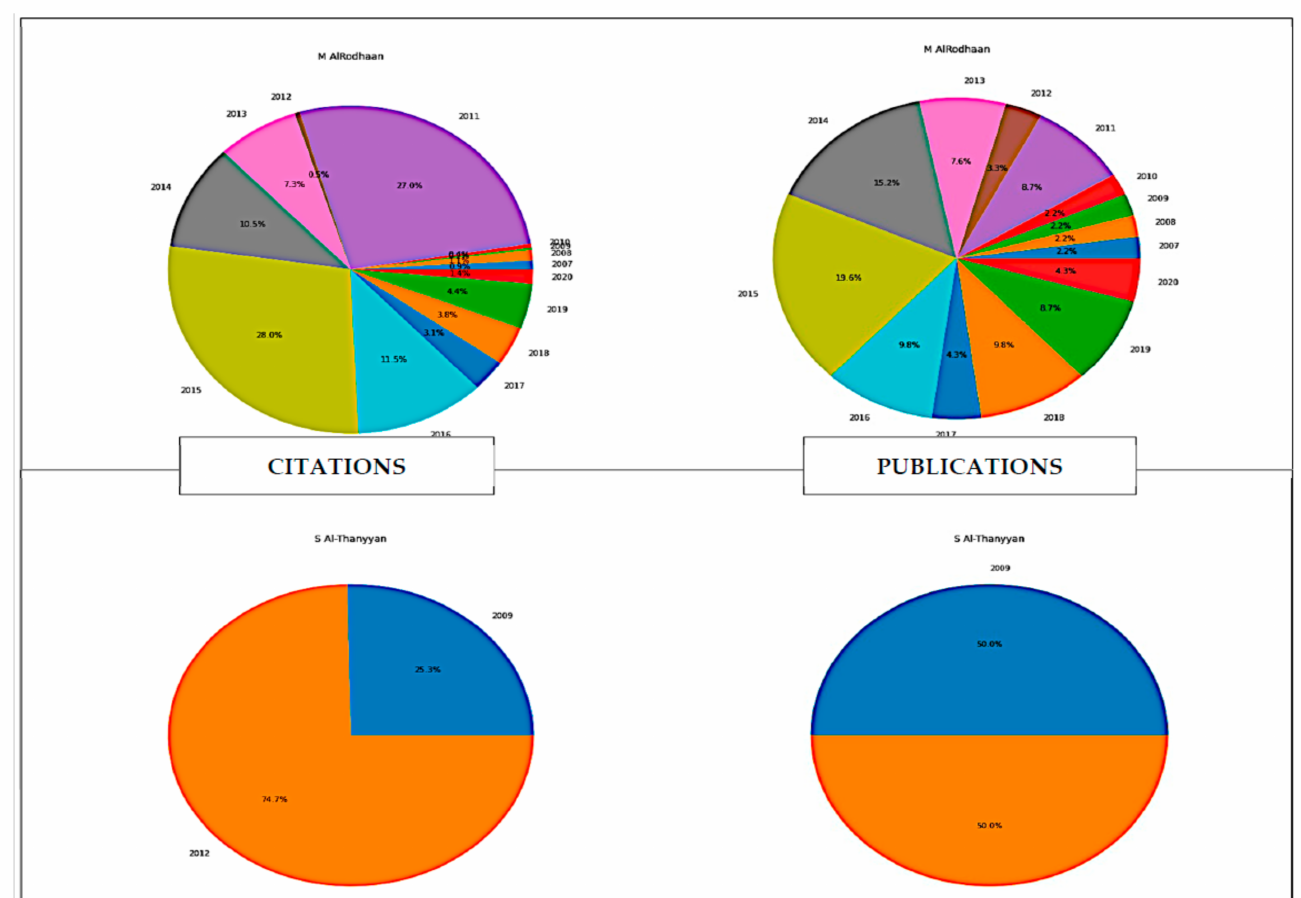
Figure 12. Two authors’ publication and citation distributions over the years.